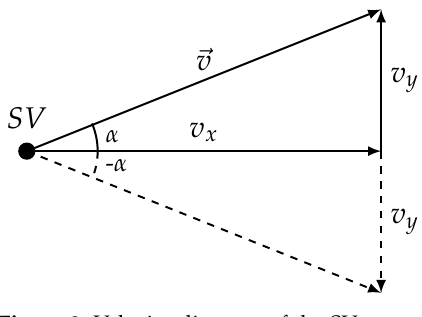
Figure 2. Velocity diagram of the